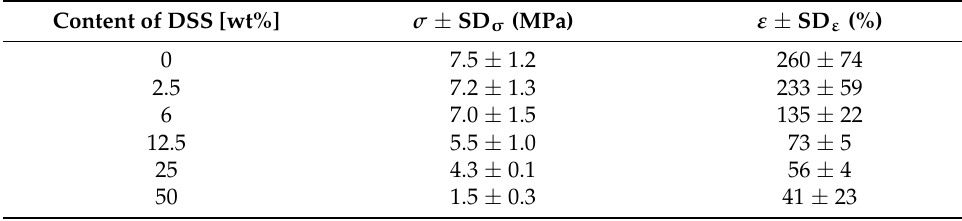
Table 3. Values of stress and strain of the investigated samples.